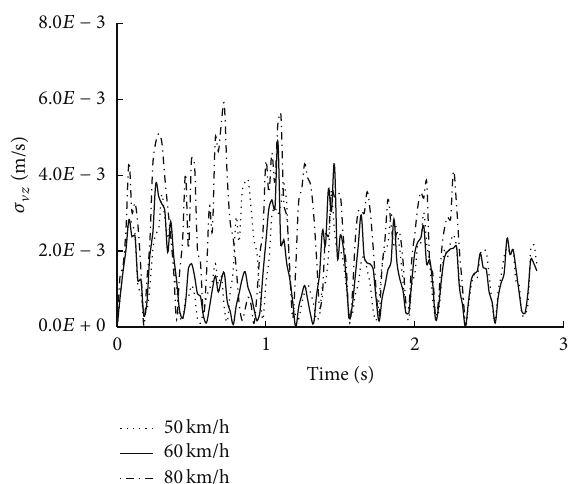
Figure 16: Standard deviation of vehicle velocity at C.G.